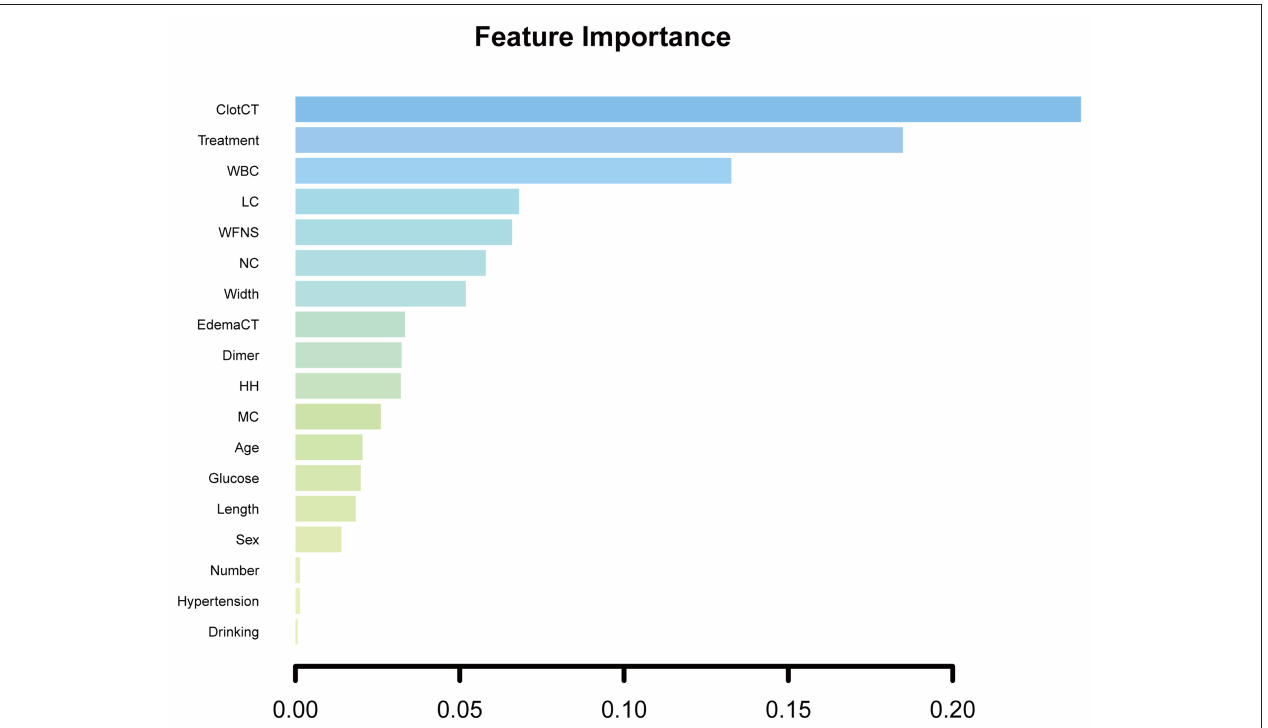
FIGURE 5 | All admission clinical feature importance. ClotCT, CT value of subarachnoid blood clot; WBC, white blood cell; LC, lymphocyte; NC, neutrophil; edemaCT, CT value of cerebral edema; HH, Hunt and Hess grade; MC, monocyte.